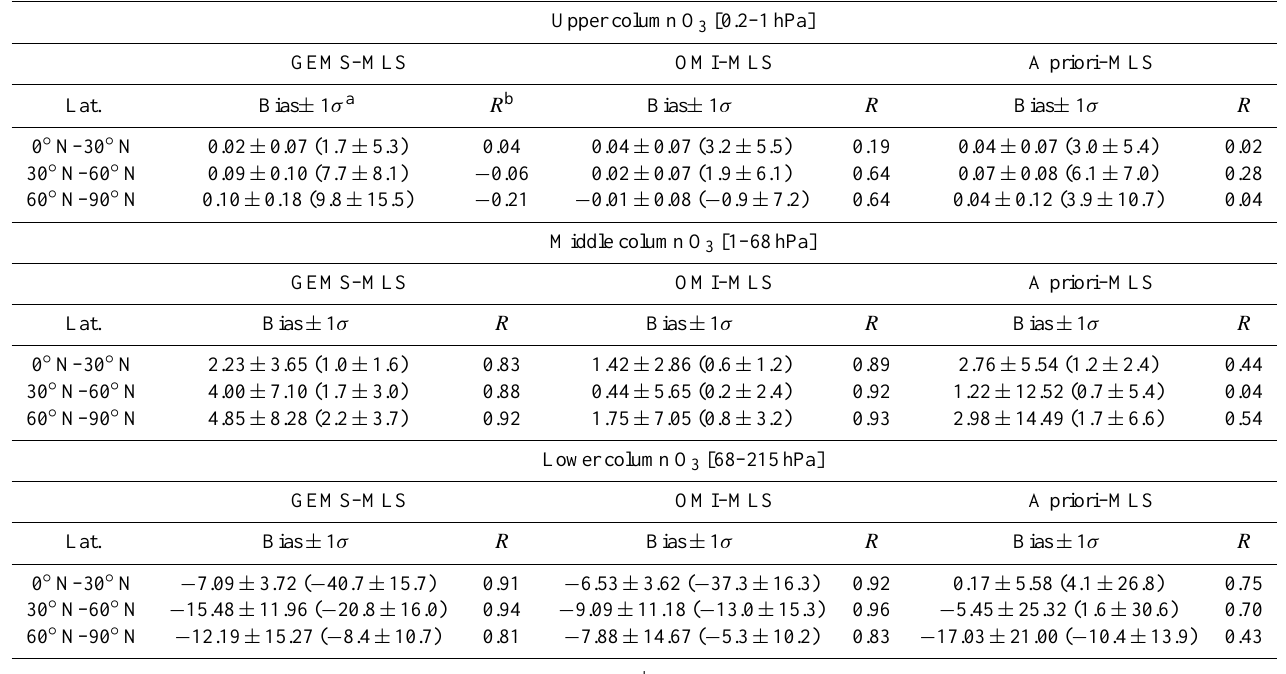
Table 1. Comparison statistics corresponding to Fig. 5.